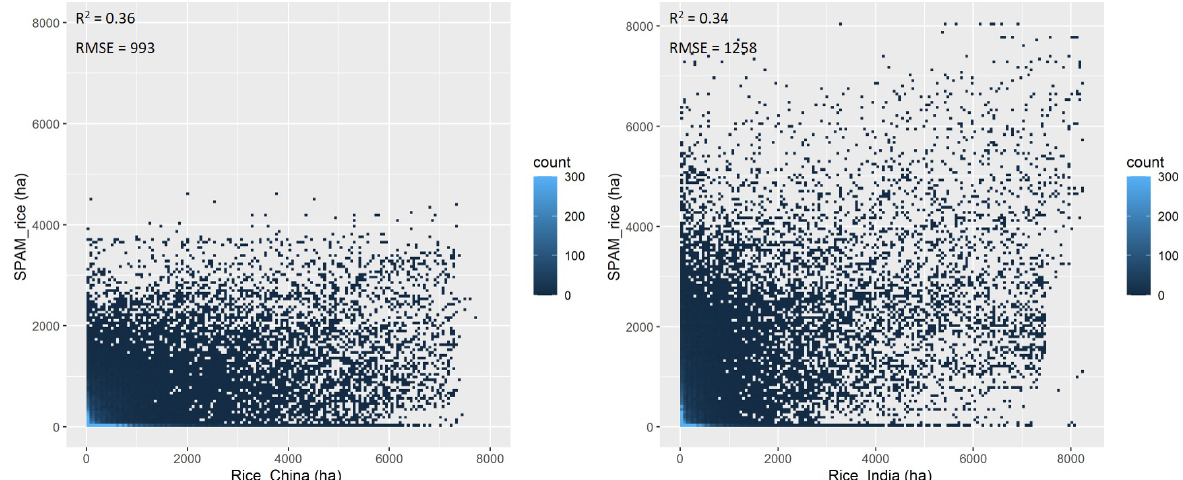
Figure 10. Grid-by-grid comparison between SPAM2010 and Zhang et al. (2017) rice area in China and